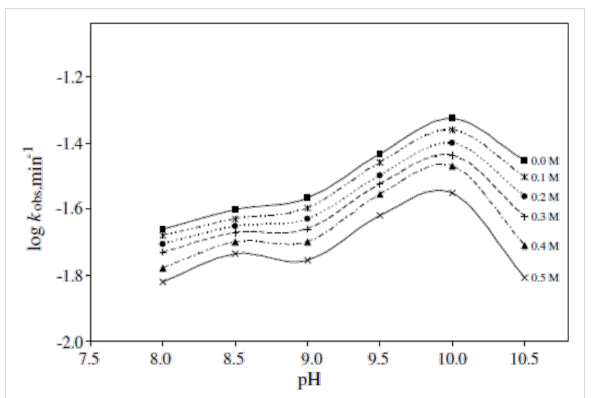
Figure 6. Reproduced with permission from [28]. Copyright 2008 Else-